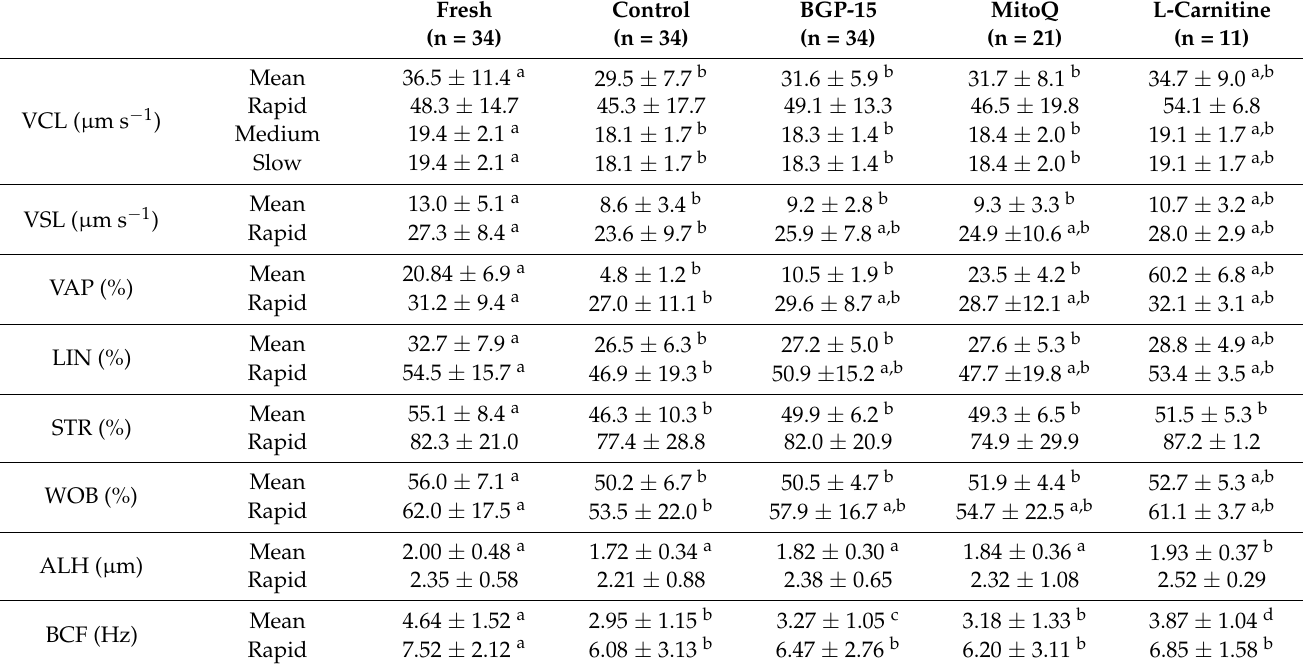
Figure 1. Effect of mitochondrial activators on sperm motility and kinetics. ( a ) Percentage of live sperm in all pre- (fresh) and post-cryopreservation samples; ( b ) Percentage of motile sperm from the total; ( c ) Percentage of progressive motile sperm from the total; ( d ) Predicted mucous penetration for motile sperm populations. Fresh (n = 34), control (n = 34), BGP-15 (n = 34), MitoQ (n = 22), L-car (n = 11). Data shown as mean ± SEM. Statistical analysis was the repeated measures mixed model with post-hoc pairwise comparisons. ★ indicates that all cryopreserved groups are significantly different from the fresh group; * p < 0.05, ** p < 0.01, **** p < 0.0001. Table 2. Mitochondrial activators affect sperm kinetics. VCL = curve speed, VSL = linear speed, VAP = average speed, LIN = linearity index, STR = straightness index, WOB = oscillation index, ALH = amplitude of lateral head, BCF = beat cross frequency. Data represented as mean ± SD. Different letters indicate significant differences between groups.